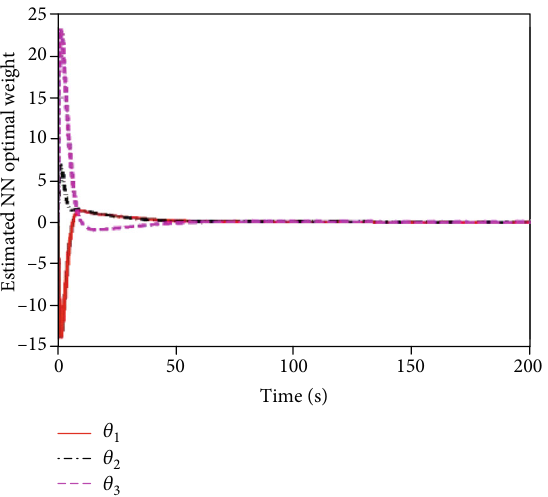
Figure 9: Time histories of angular velocities in Case 2.